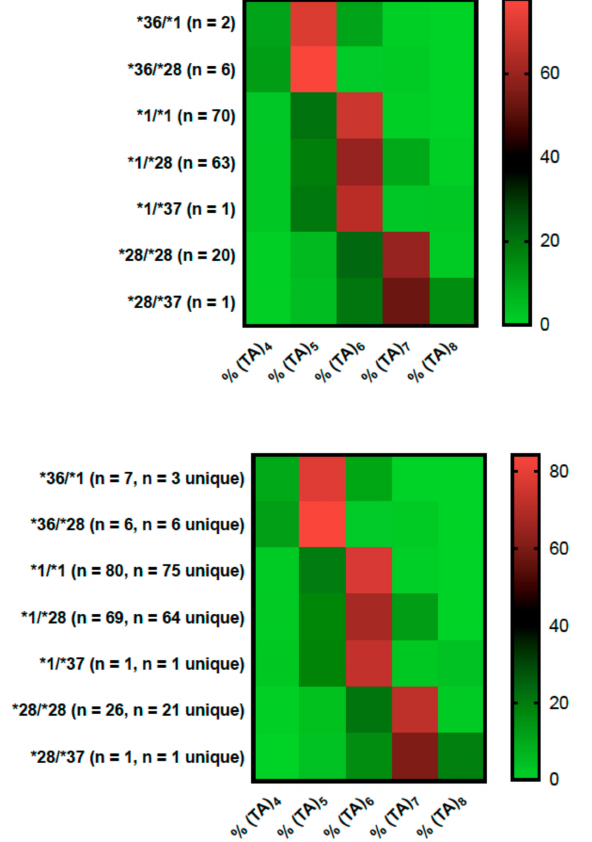
Figure 1. Heatmaps representing the % (TA) n in (A) Illumina sequencing and (B) fragment analysis. Controls (for UGT1A1*36 / *1 , UGT1A1*1 / *1 , UGT1A1*1 / *28 , UGT1A1*28 / *28 ) were repeated in multiple assays for fragment analysis; hence, there are di ff erences in experimental